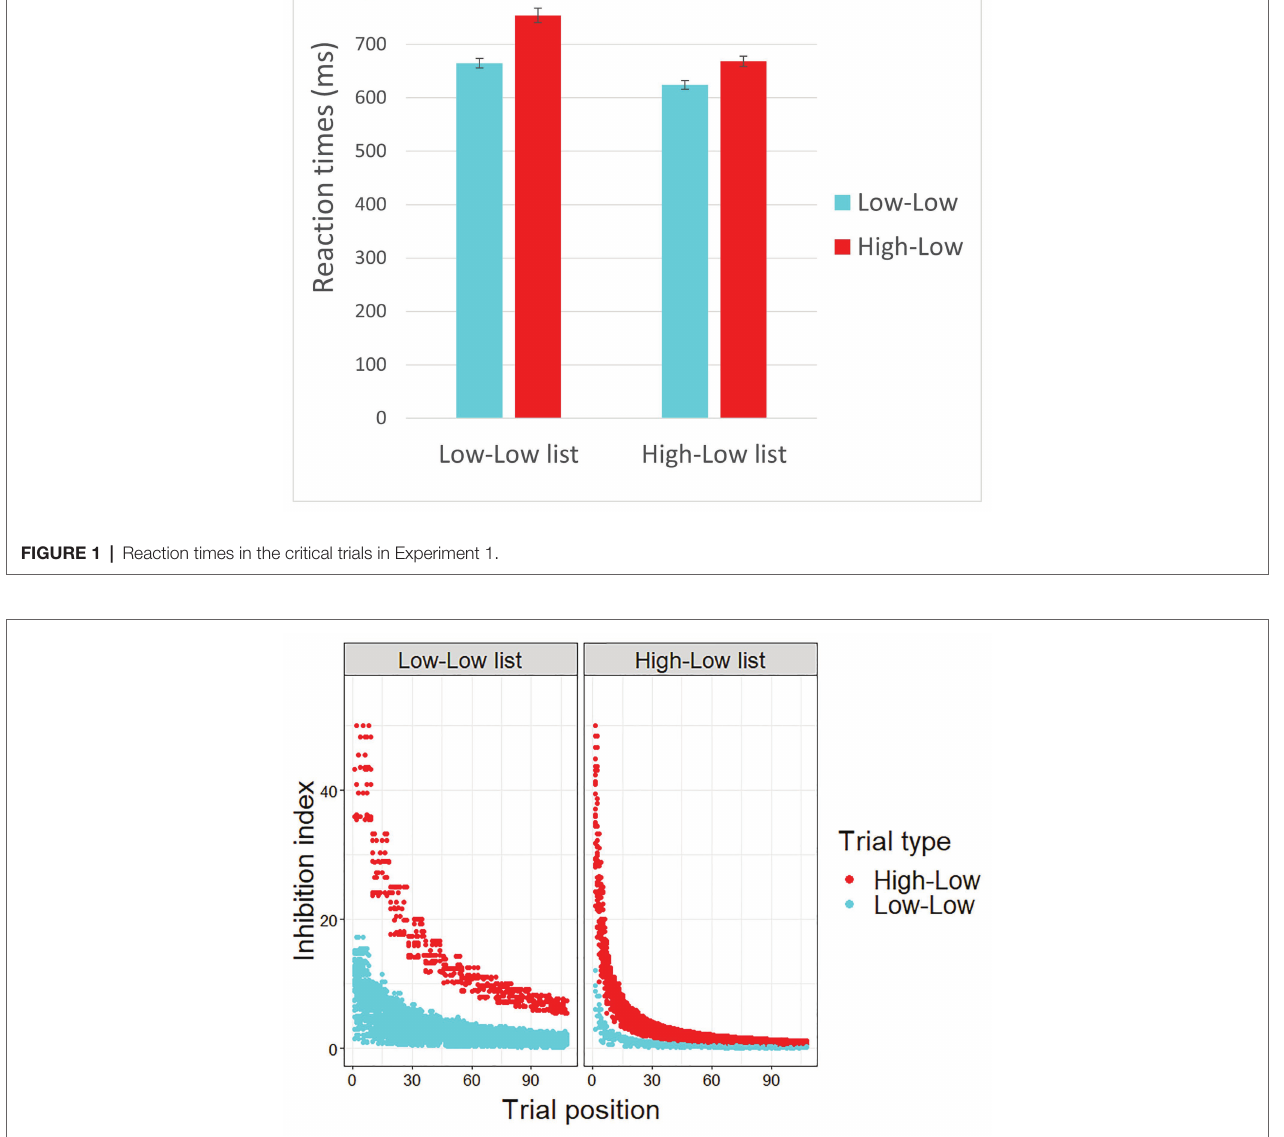
FIGURE 2 | Calculated inhibition index ( μ *PE) in Experiment